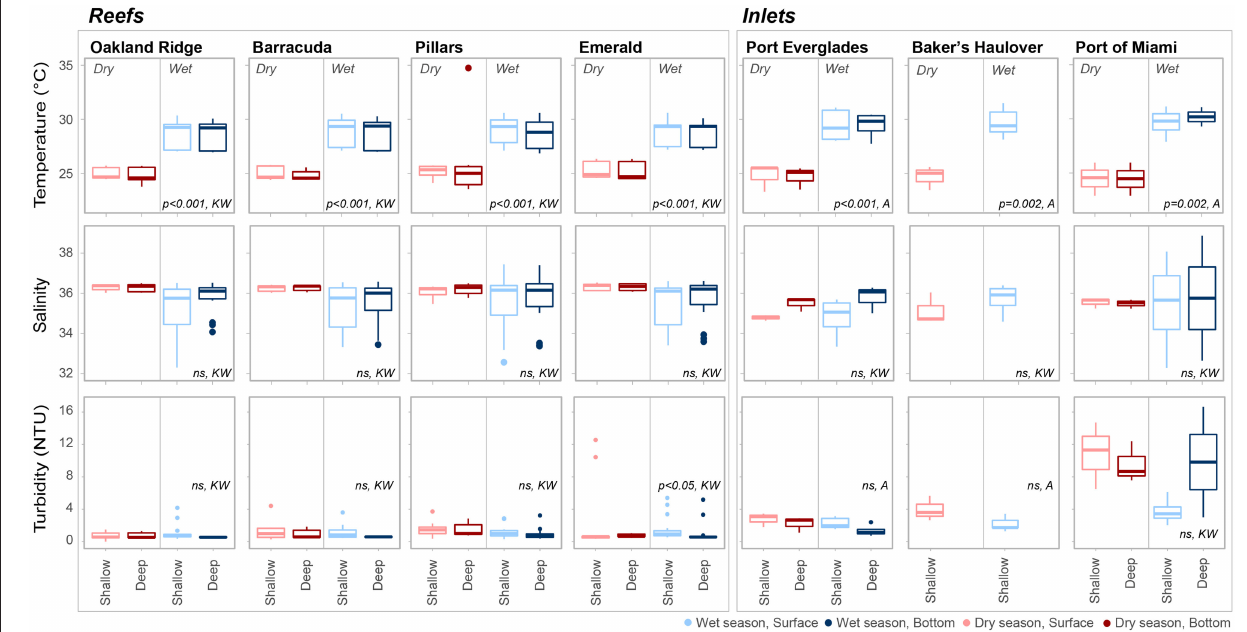
Frontiers in Marine Science |